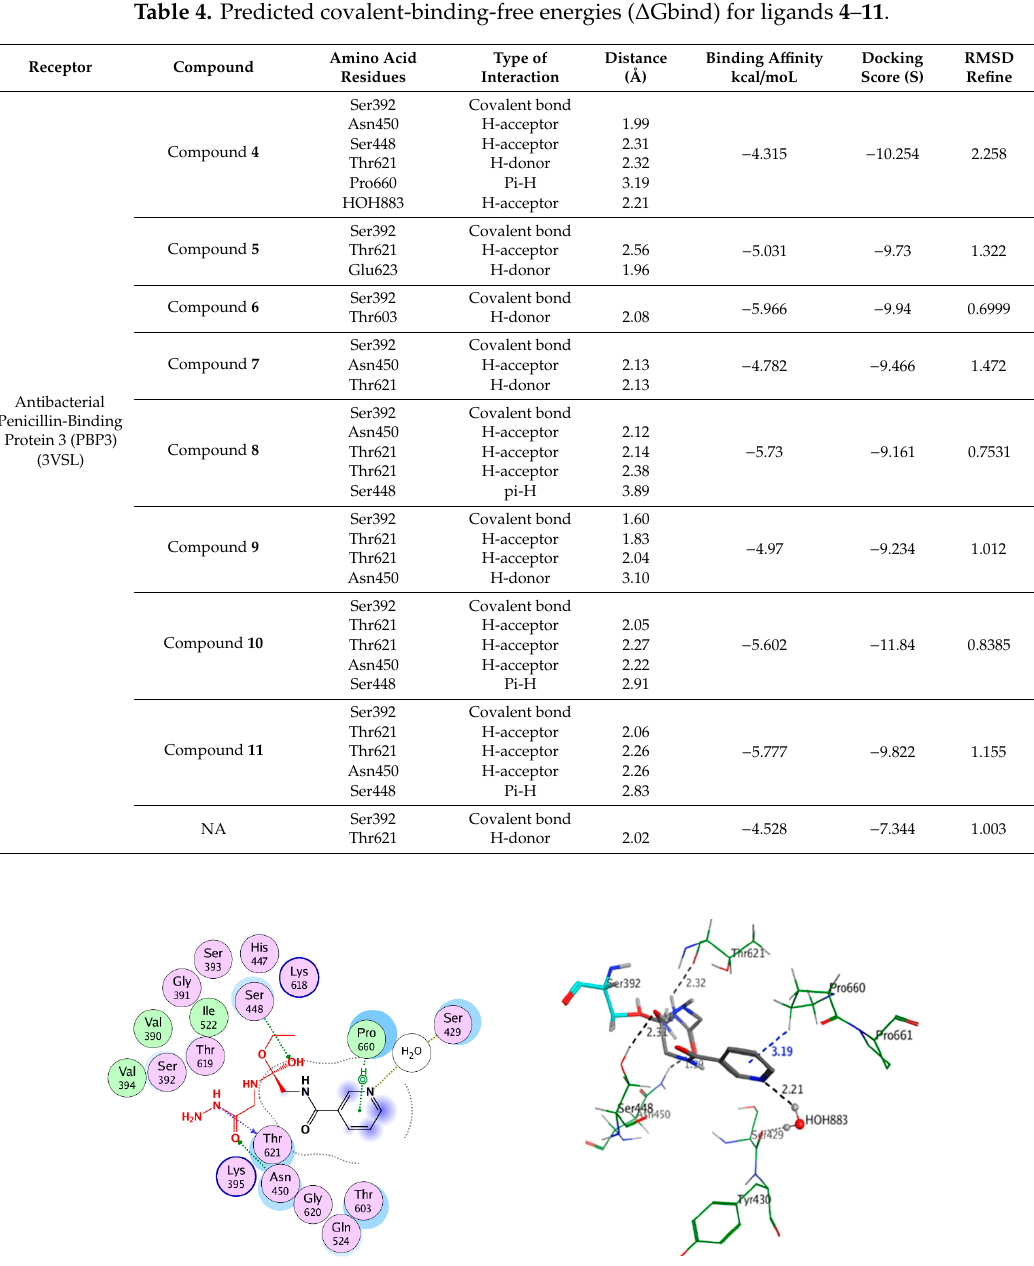
Figure 9. 2D and 3D covalent interaction of compound 4 with 3VSL.